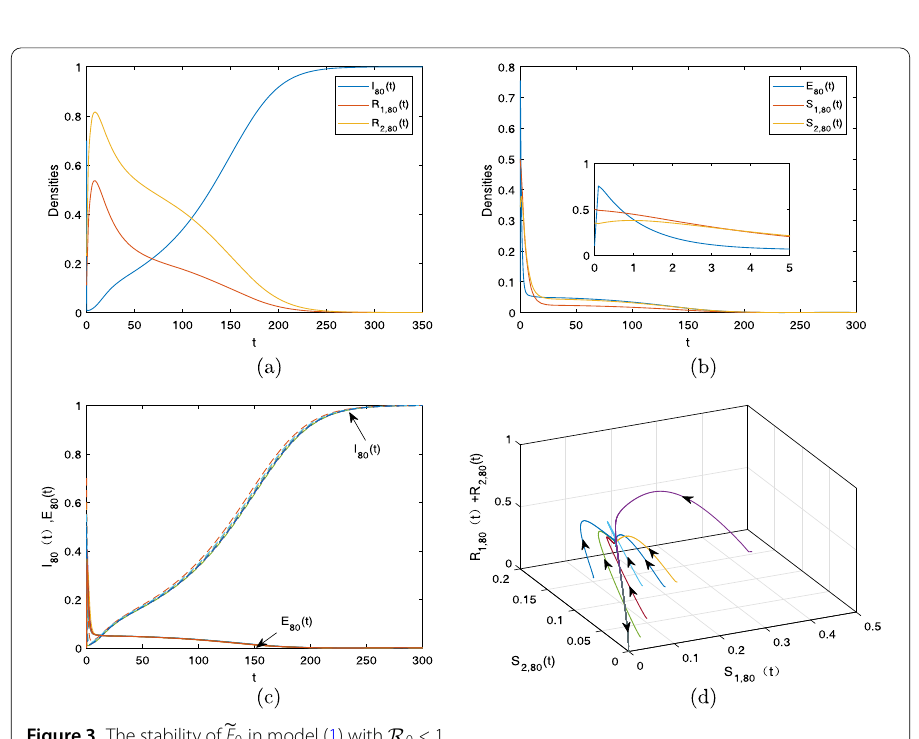
Figure 3 The stability of (cid:18) E 0 in model (1) with R 0 < 1